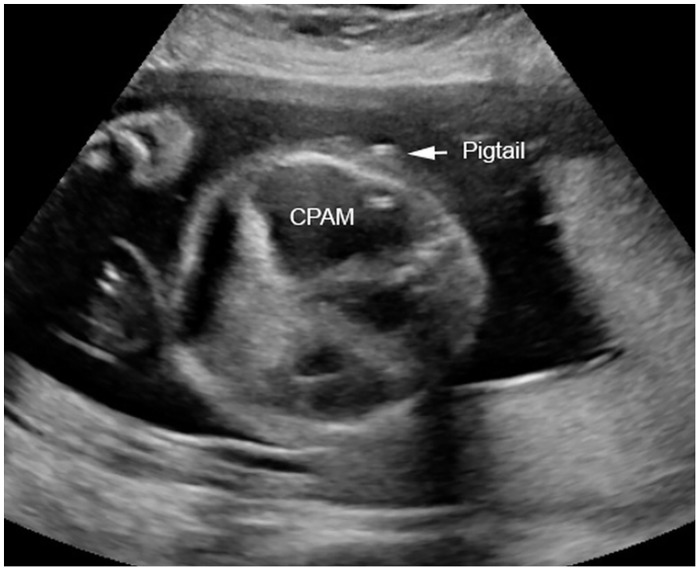
Transverse section of the fetal thorax at 25 weeks of gestation demonstrating a macrocystic congenital pulmonary airway malformation (CPAM) drained by an inserted double pigtail catheter (Harrison Fetal Bladder Stent Set).